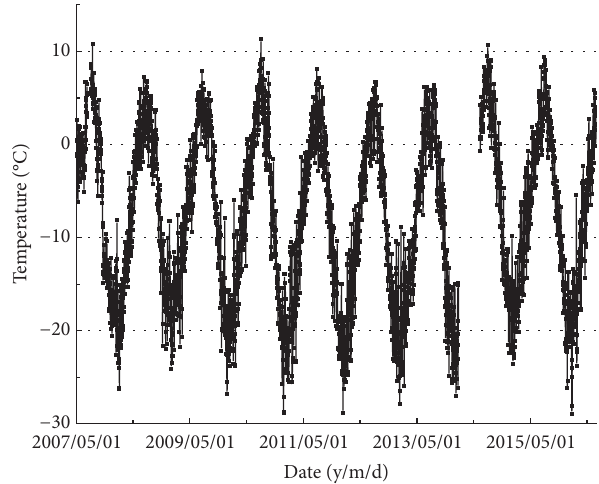
Figure 2: Air temperature changers of section K1068